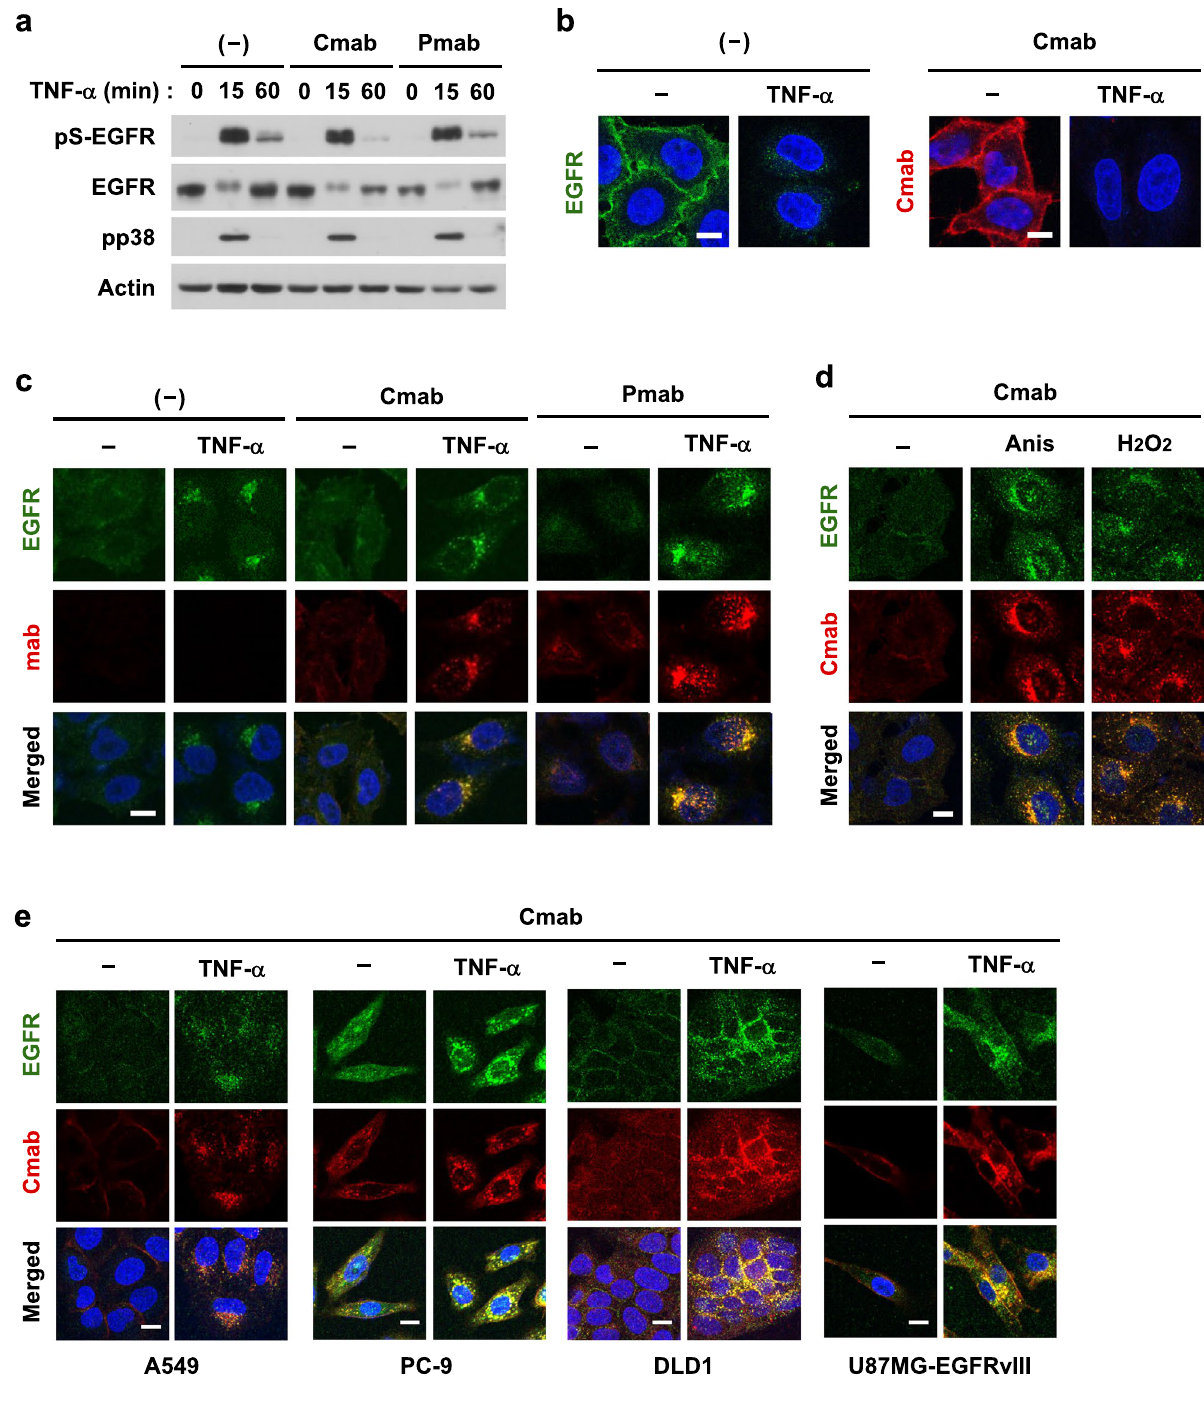
Figure 2. Internalization of anti-EGFR antibodies by cellular stress. ( a ) HeLa cells were pretreated with 100 nM cetuximab (Cmab) or 30 nM panitumumab (Pmab) for 10 min and then stimulated with 20 ng/mL TNF-α for 15 or 60 min. The expression of the indicated proteins was detected by immunoblotting. pS-EGFR shows Ser-1015-phosphorylated EGFR. Original blots are published in Supplementary Fig. S3. ( b , c ) HeLa cells were pretreated with cetuximab or panitumumab for 10 min and then stimulated with TNF-α for 15 min. ( d ) HeLa cells were pretreated with cetuximab for 10 min and then stimulated with 50 µM anisomycin for 30 min or on the cell surface ( b ) and in intracellular compartments ( c – e ) was investigated by immunofluorescence. Scale bar = 10